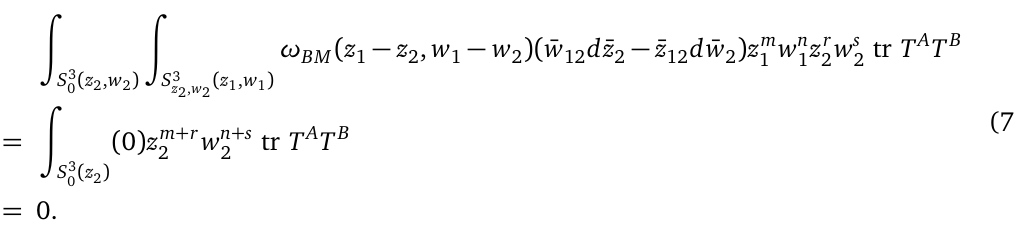
Figure 3: The S 3 contour rearrangement. S 3 ( z and parametrized by z